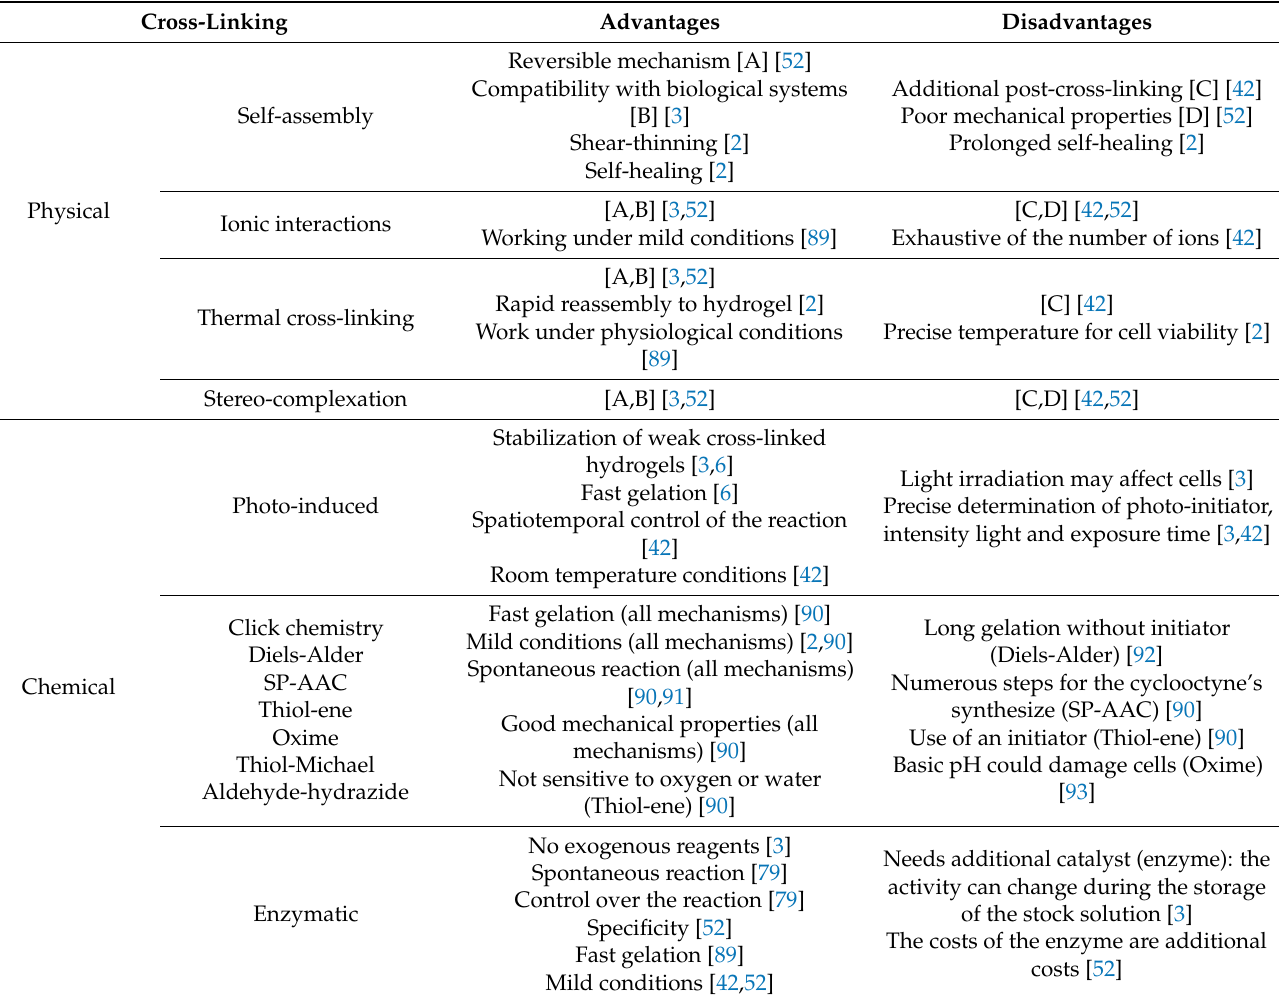
Table 1. Advantages and disadvantages of physical and chemical